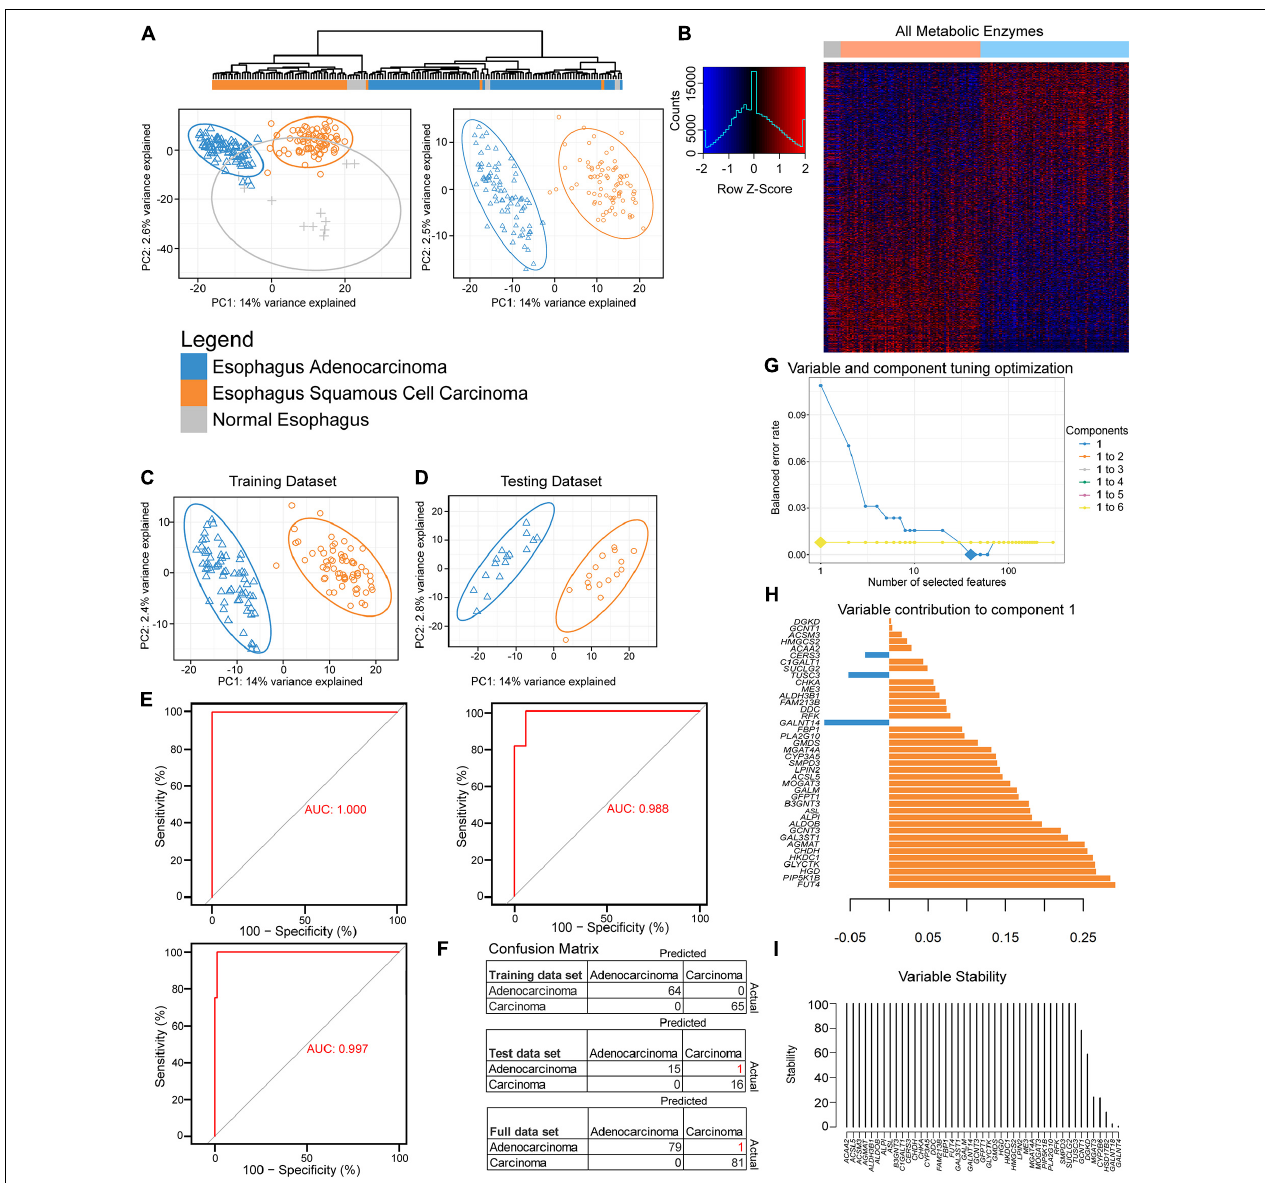
FIGURE 1 | Partial least-squares discriminant analysis (PLS-DA) reveals histological differences for metabolic enzymes. (A) Hierarchical and PLS-DA clustering of enzyme mRNA levels between esophageal adenocarcinoma (EAC), esophageal squamous cell carcinoma (ESCC), and normal tissue (left) and just the histological subtypes (right). (B) Heatmap row Z-scores of log 2 mRNA expression. (C,D) PLS-DA containing scaled log 2 enzyme mRNA for 80% of each histological subtype that was randomly sent to training (C) , while the remainder went to the testing dataset (D) . (E) The receiver operating characteristic (ROC) curve of the training (upper left), testing (right), and the full dataset (bottom). (F) The confusion matrix with incorrect predicted classifications shown in red after tuning the sparse partial least-squares discriminant analysis (sPLS-DA). (H) The optimal combination of one component and 40 enzyme expression was further examined for their eigenvalues (influence) on component 1. (G) The balanced error rate for the first six components with 1–10, 20, 30, 40, 50, 60, 70, 80, 90, 100, 110, 120, 130, 140, 150, 160, 170, 180, 190, 200, or 300 enzyme mRNA expression(s) included in the tuned sPLS-DA. Large diamonds indicate the lowest error rate for the given component and number of enzymes. Components 3–6 could not decrease the balanced error rate further and are hidden behind the line of the second component. (I) The 40 enzymes in component 1 were examined for